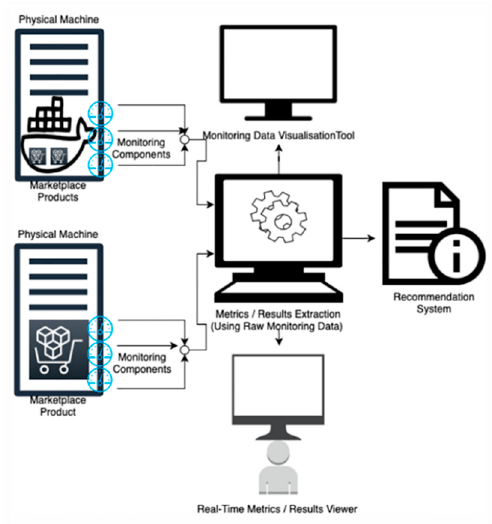
Figure 8. Service’s Evaluation and Monitoring System ( SEMS) general architecture.